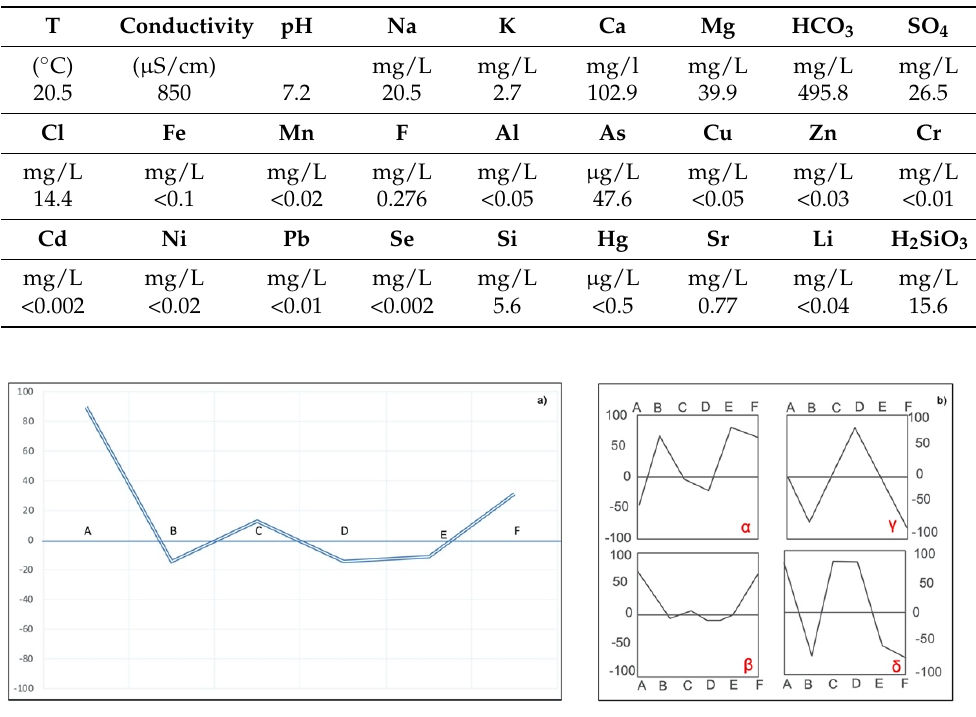
Legend for Figure 9a: A—indicates that geothermal waters had circulated through a calcareous terrains rather than an evaporative one; B—indicates that the geothermal water is enriched by sodium and may come from sedimentary terrains; C—is low, which excludes water deriving from a flysch, volcanite or schistose basement; D—indicates water circulation through dolomite; E— indicates that geothermal water had circulated in a carbonated reservoir rather than in a sulfated one; F—no indication in growth of potassium content, which excludes possible circulation in granitic field. Figure 9. ( a ) D’Amore parameters diagram of chemical analyses; ( b ) α : evaporative terrains; β circulation in limestone; γ : circulation through a crystalline basement; δ : circulation in argillaceous rocks.